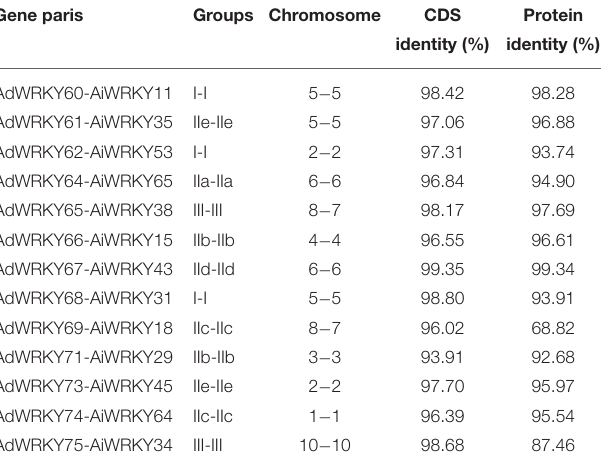
Protein identity (%) identity